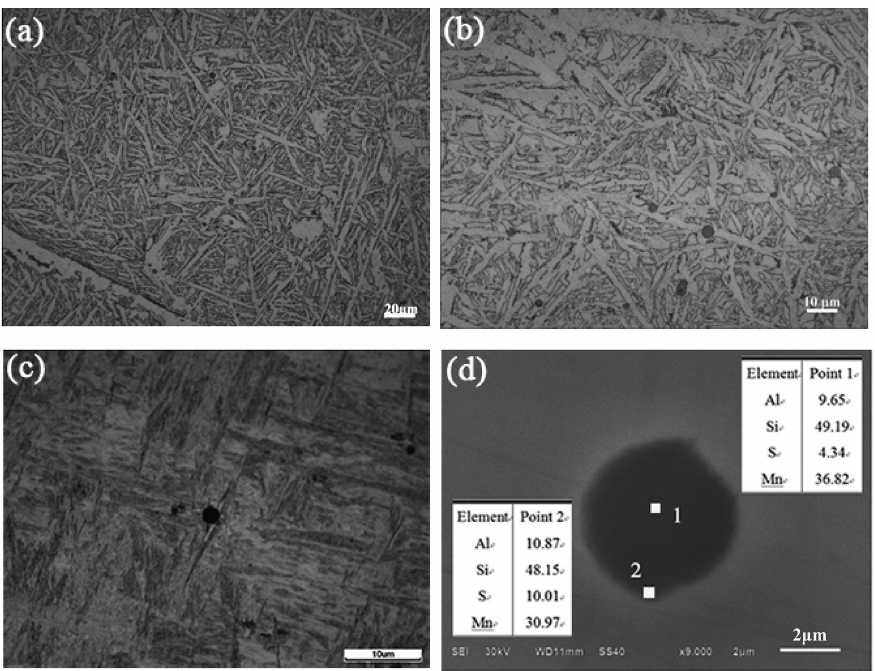
Figure 3: (a – b) The Mg-treated sample ’ s optical microstructure, (c) The comparison sample ’ s optical microstructure, (d) The SEM micrograph for typical Al-Si-Mn-O inclusion in comparison